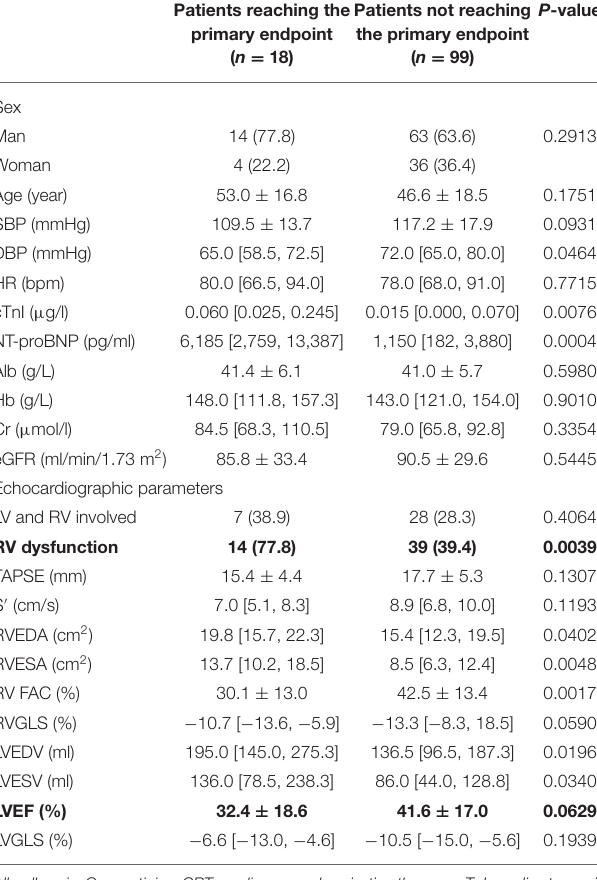
Alb,albumin;Cr,creatinine;CRT,cardiacresynchronizationtherapy;cTnI,cardiactroponin I; DBP, diastolic blood pressure; eGFR, estimated glomerular filtration rate; FAC, fractional area change; Hb, hemoglobin; HR, heart rate; ICD, implantable cardioverter-defibrillator; LVEDV, left ventricular end diastolic volume; LVESV, left ventricular end-systolic volume; LVEF, left ventricular ejection fraction; LVGLS, LV global longitudinal strain; NT-proBNP, N- terminal fragment of pro-hormone brain natriuretic peptide; RV, right ventricular; RVEDA, right ventricular end-diastolic area; RVESA, right ventricular end systolic area; RVGLS, RV global longitudinal strain; SBP, systolic blood pressure; TAPSE, tricuspid annular plane systolic excursion. Bold values mean parameters with statistical significance and clinical significance towards